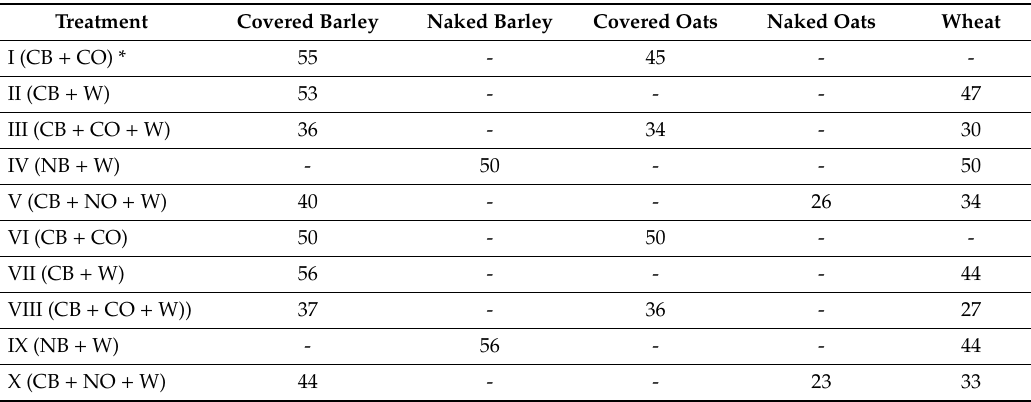
Table 4. Yield sharing (%) of each partner in a mixture on Albic Luvisols (average 2013–2015). Treatment Covered Barley